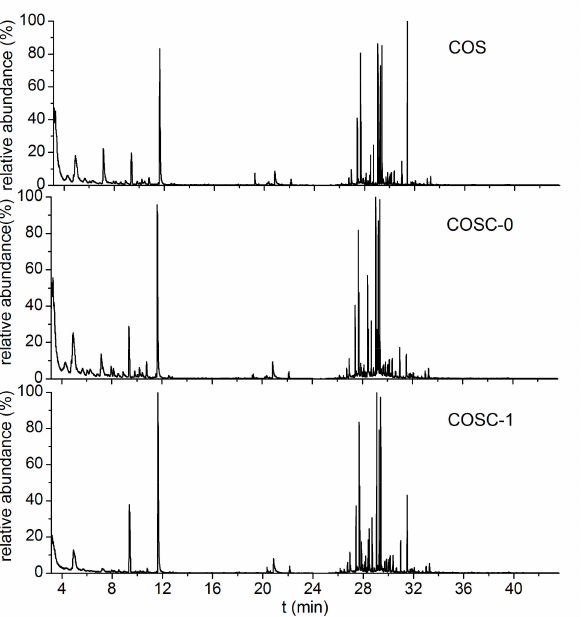
Figure 4. Total ionic chromatogram of absorbent components after treating cooking fumes.